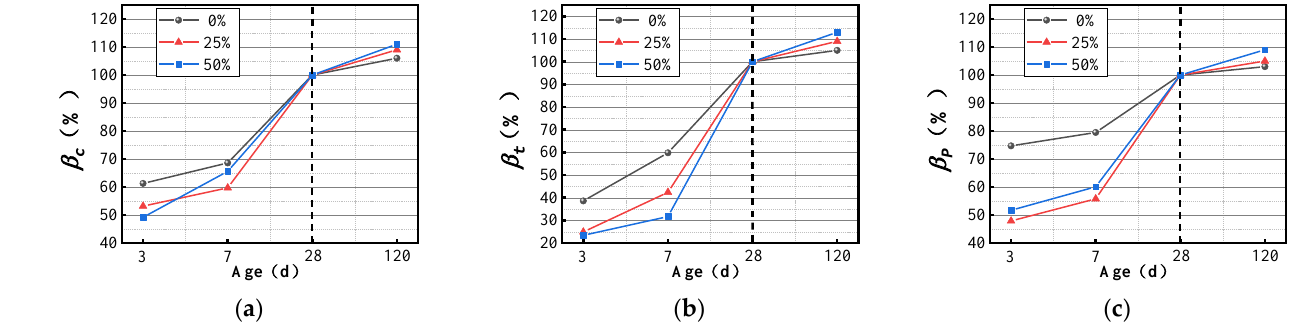
Figure 9. Development coefficient of strength for each category: ( a ) β c ; ( b ) β t ;( c ) β F.